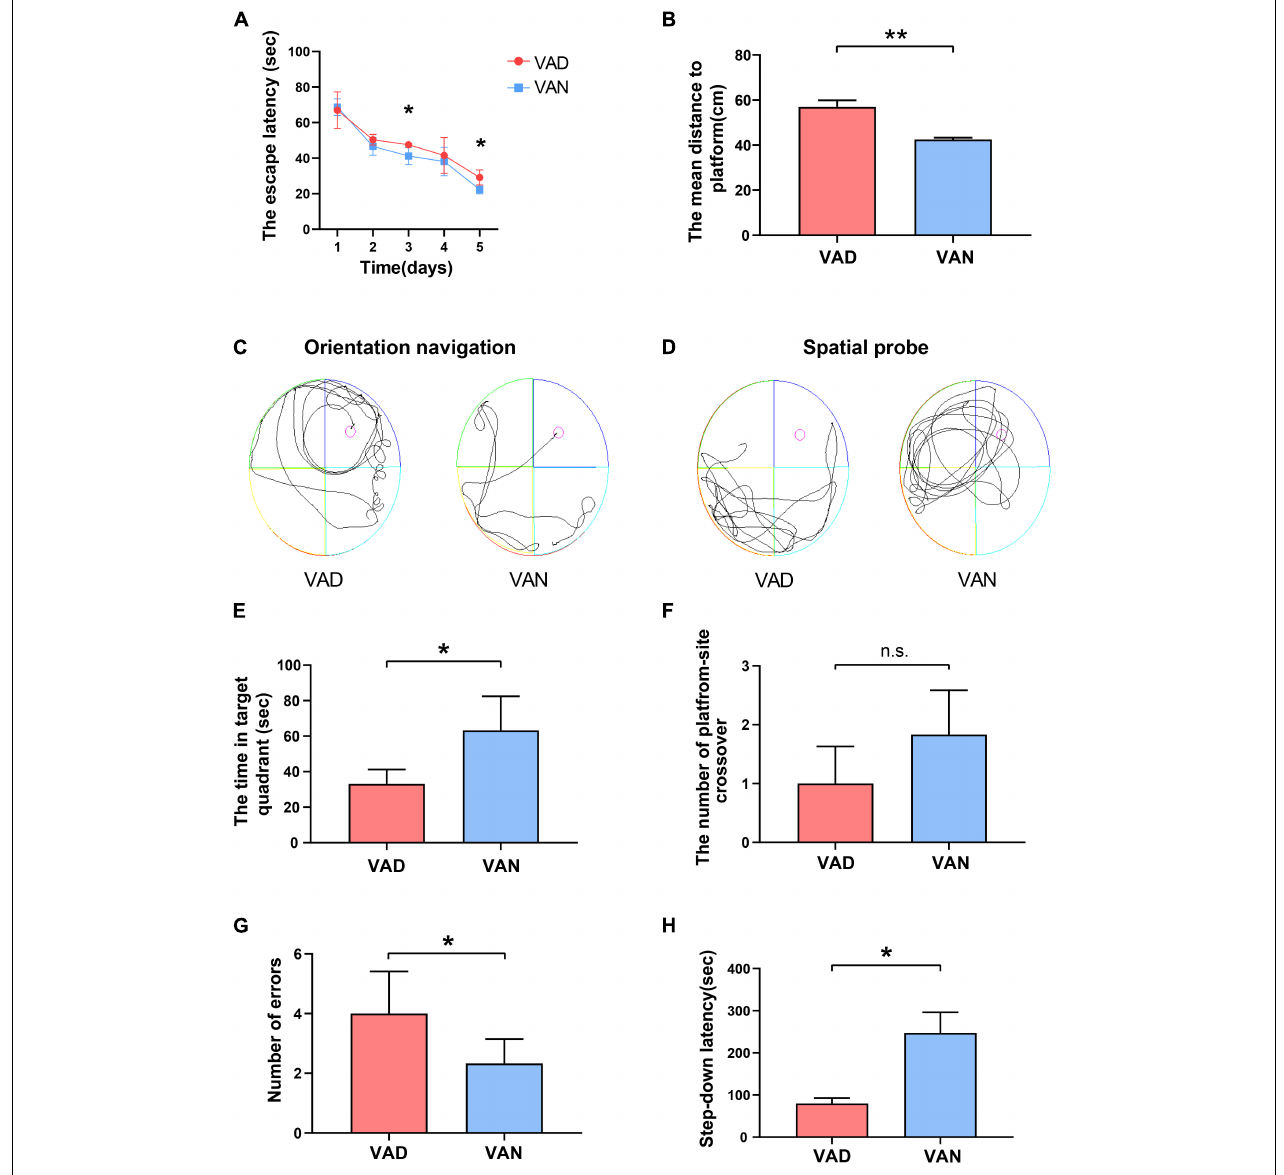
FIGURE 4 | Consumption of the VAD diet for 45 weeks aggravated the learning and memory deficits of the APP/PS1 transgenic mice. (A) The escape latency (time to reach the escape platform over days) in the Morris water maze (MWM) test. (B) The escape distance in the MWM test. (C) The orientation navigation path in the MWM test. (D) The spatial probe path in the MWM test. (E) The target-quadrant abidance was measured in the MWM test. (F) The crossing-target number was measured in the MWM test. (G) The error frequency to step down was measured in the step-down passive avoidance (SDPA) test. (H) The latency of the step-down response was measured in the SDPA test. VAD, vitamin A deficiency diet; VAN, vitamin A normal diet. n = 10 per group. ∗ P < 0.05, ∗∗ P < 0.01, and n.s.,